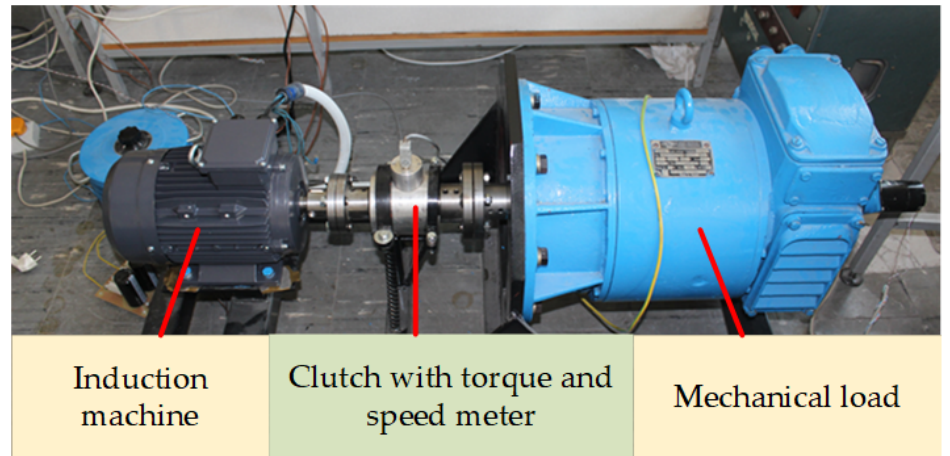
Figure 17. The electromechanical system on which the DOL starting with delay of phase voltage switching was tested.